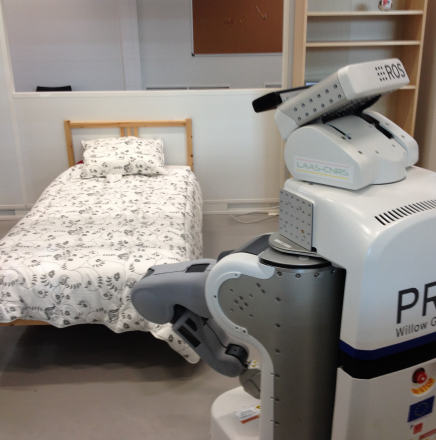
Figure 1. A service robot in a home-like